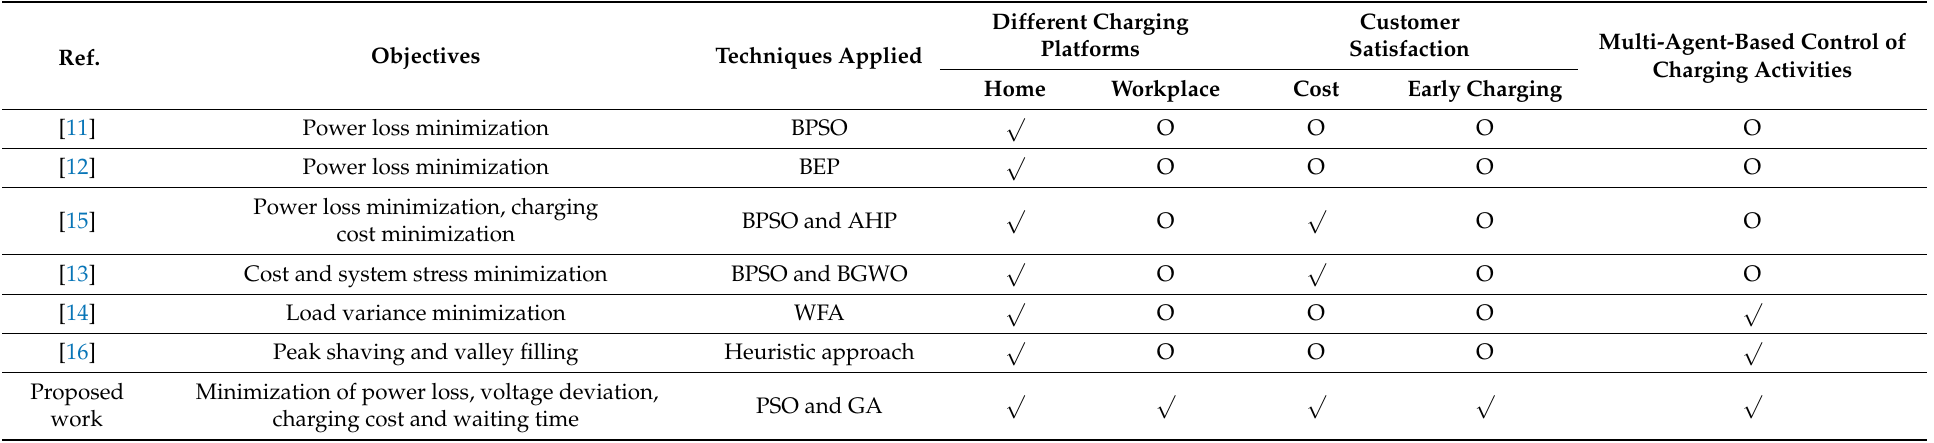
Table 7. Comparison of proposed work with the reported